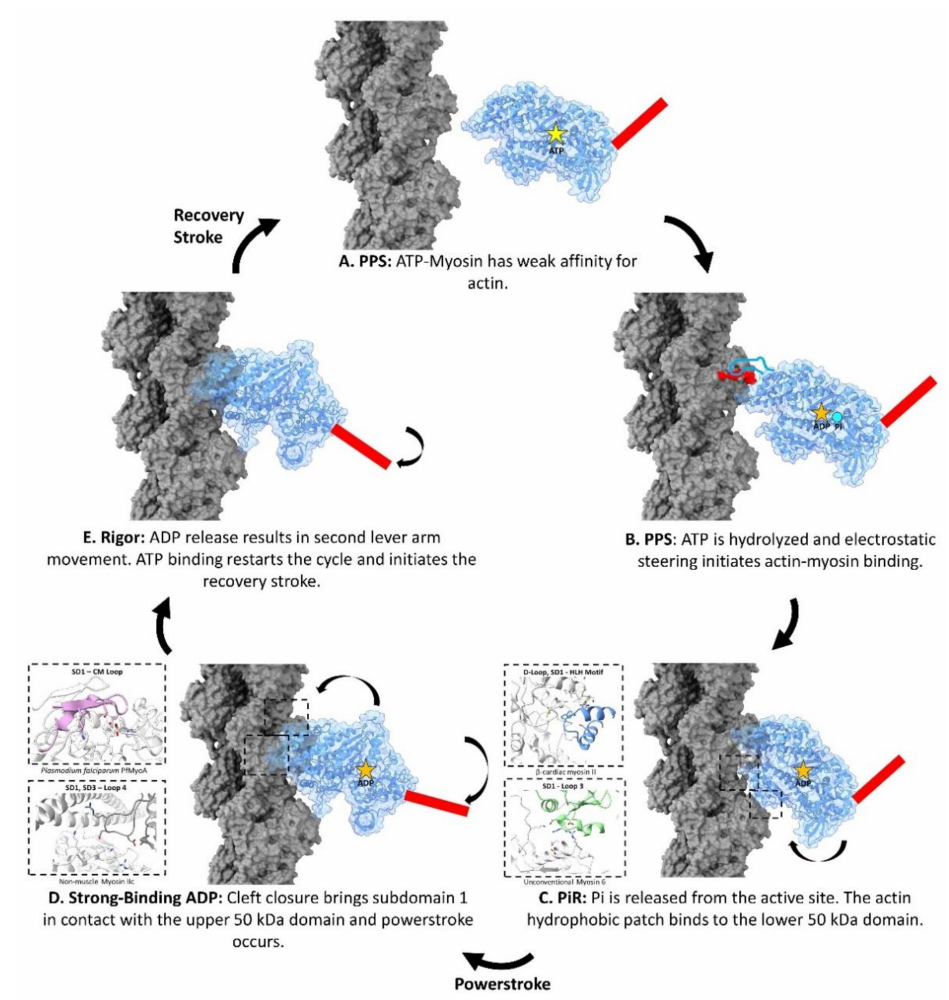
Figure 3. Proposed binding mechanism of the actin-myosin complex. The myosin motor domain structural rearrangements are depicted for each step of the motor cycle. The surface of myosin in transparent blue shows the secondary structure of the protein. The lever arm is indicated as a red bar. The surface of the actin filament is depicted in grey. ( A ). Pre-powerstroke state (PPS) myosin with bound ATP (yellow star) has a very weak affinity to the actin surface. The cleft between the upper and lower 50 kDa domains is open and the lever arm is in the primed pre-powerstroke state conformation. This PPS state is depicted using the PDB: 5N6A [82]. ( B ). PPS myosin hydrolyzes ATP to ADP-Pi. Electrostatic steering between the acidic patches on the actin surface and myosin surface loop 2 initiates binding between actin and myosin. The acidic patch of actin subdomain 1, containing the N-terminus of actin as well as residues D24, D25, and E334 are indicated in red on the actin filament. Loop 2 of myosin is depicted as a cartoon (blue), while the ADP and Pi molecules are depicted as an orange star and cyan circle respectively. This PPS state is depicted using the PDB: 5N6A [82]. ( C ). Pi is released from the active site to create the PiR intermediate state. According to the currently proposed binding mechanism, the hydrophobic patch at the junction of actin subunits binds to the lower 50 kDa domain HLH motif. Loop 3 and the activation loop are also brought to the actin surface. The insets describe the binding of the β -cardiac myosin II isoform (PDB: 6X5Z, 7JH7) [83,84] HLH motif and unconventional myosin 6 (PDB: 6BNP) [85] loop 3 as examples. The PiR state is depicted using the PDB: 4PFO [72]. ( D ). The powerstroke and cleft closure occurs producing the strong-binding ADP state. The lever arm undergoes its major swing, the powerstroke. Total cleft closure is also induced by stabilization of the strut and the binding of the upper 50 kDa domain to actin subdomain 1. Upper 50 kDa binding is accomplished through conserved hydrophobic contacts between actin subdomain 1 and the CM loop. Myosin loop 4 is also brought close to actin-tropomyosin. The